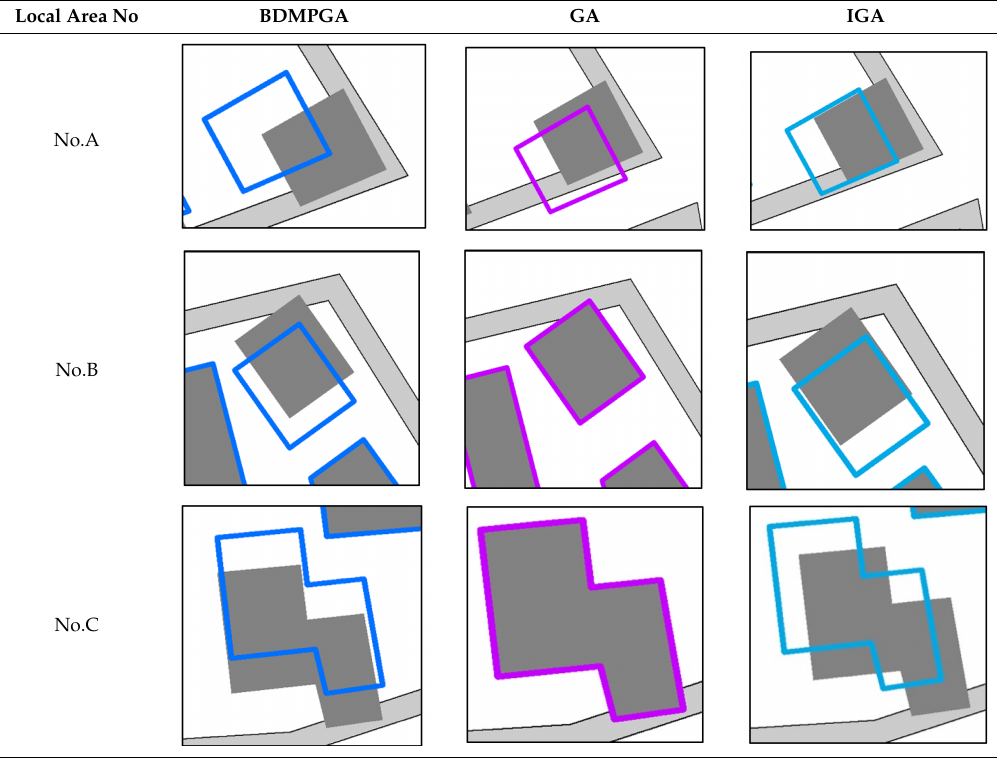
Table 5. Comparison of typical displacement examples based on the three di ff erent methods.